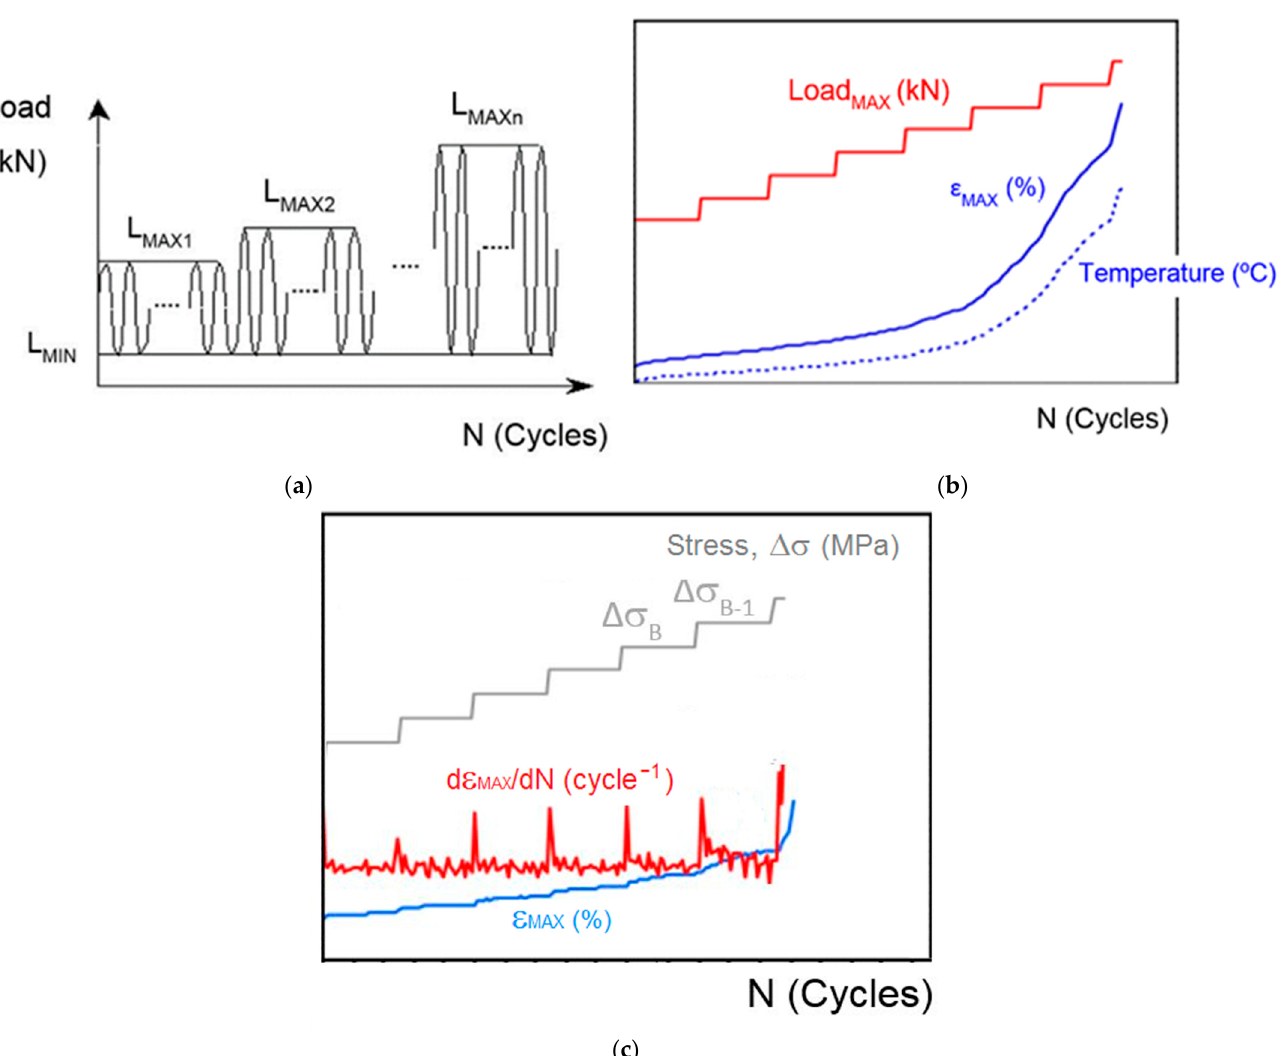
Figure 2. Schematic description of the accelerated fatigue LOCATI test. ( a ) Blocks of loading, ( b ) parameters measured and ( c ) definition of fatigue strength. ( b ) parameters measured and ( c ) definition of fatigue